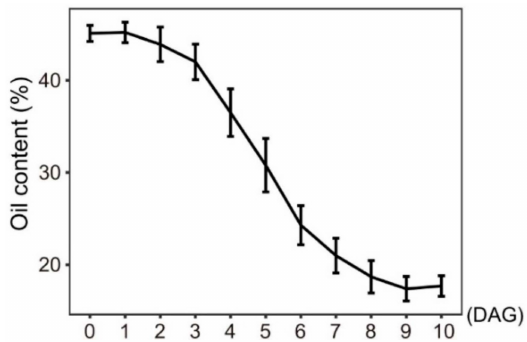
Figure 5. Oil content of germinating endosperm. DAG: days after germination. Bars = means ± SD from three biological